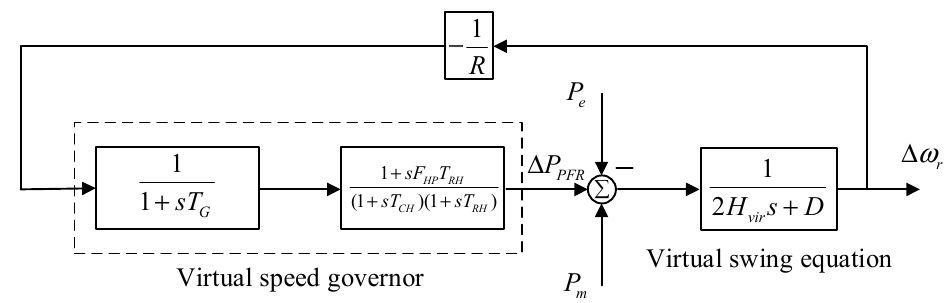
Figure 1. Control structure of active power-frequency control.